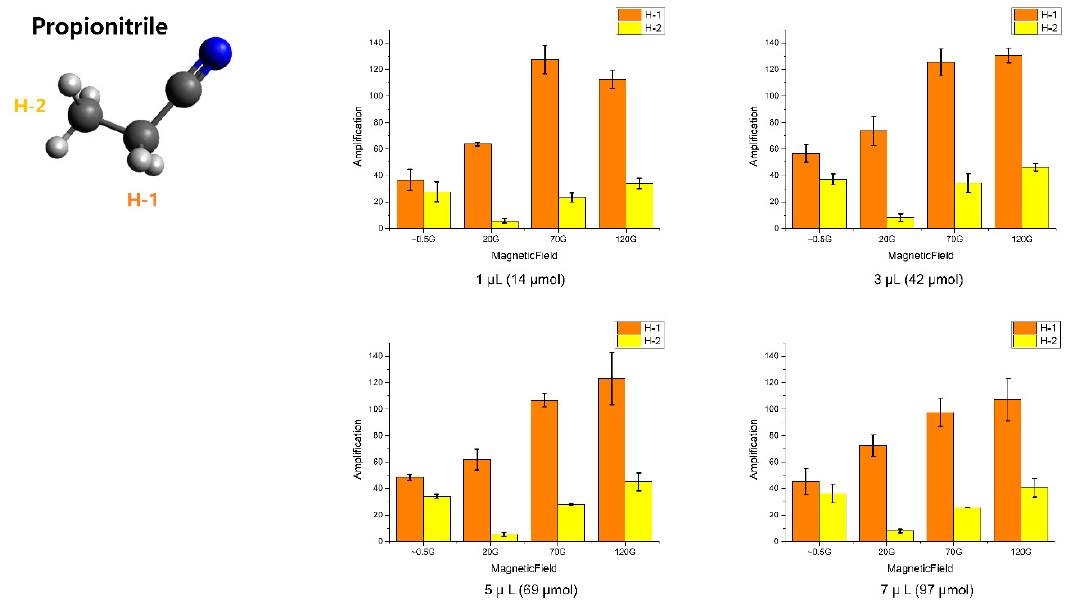
Figure 4. Amplification factors according to the different magnetic fields for different amounts of propionitrile in solvent (MeOH- d 4 ).